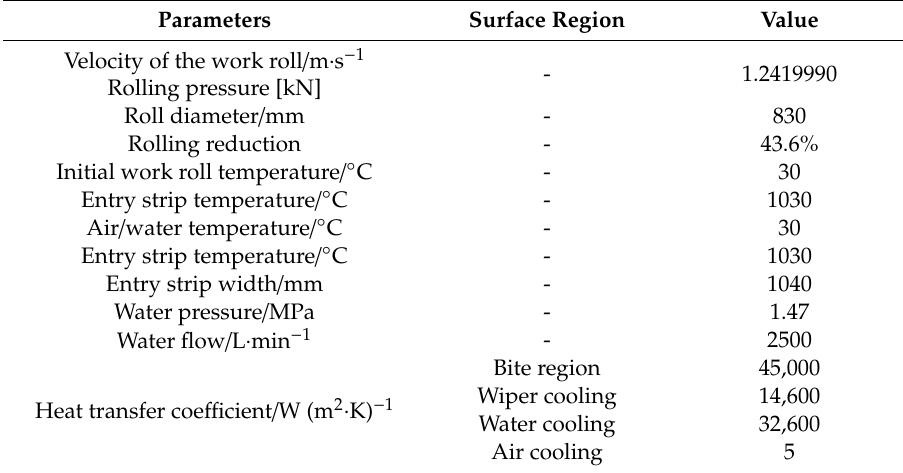
Table 3. Parameters of the work roll during hot